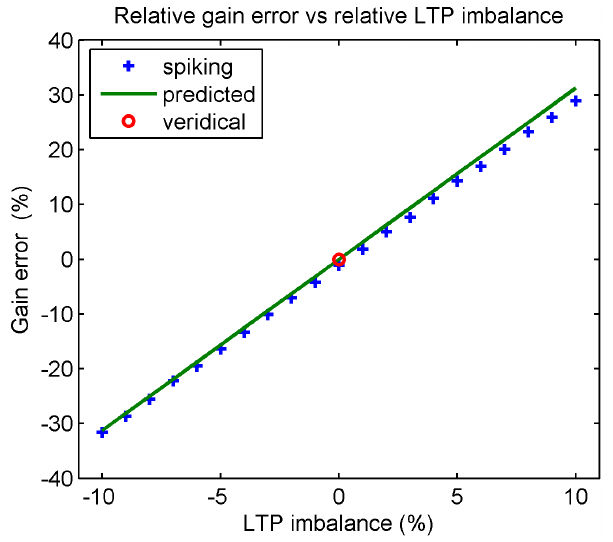
Figure 12. Effect of LTP/LTD imbalance: Stability of brainstem learning rule in the closed loop. The blue crosses show the result of applying the iSTDP learning rule with varying levels of LTP/LTD imbalance to an MVN neuron with a unit amplitude 3 Hz sinusoidal vestibular input x . As outlined in Fig. 10 the corrective cerebellar input was set to y ~ w { g ð Þ x as w varied during learning. Both x and y were Poisson rate-coded with tonic rates of 50 spikes/sec and a modulation depth of 40 spikes/sec. LTP imbalance was measured as the percentage excess of the area of the positive Gaussian over the negative Gaussian in theiSTDPprofile (otheriSTDPprofile parameters werechosenasinFig.8). The target gain was g ~ 1 . For moderate levels of imbalance learning produced a stable limitingweight w . Forzero imbalance the target gain is all expressed in the MVN weight w , hence we used 100 w { g ð Þ as a measure of the percentage weight error caused by the imbalance. This is also the percentage VOR gain error that would be observed if the cerebellar contribution was removed. The observed linear dependence is well predicted by the idealised iSTDP profile shown in Fig. 2 (green curve) for which the learned weight can be calculated analytically as m x m y w ~ 1 z e where k x , k y are the peak modulations of the two inputs k x k y and e is the relative imbalance in LTP. Weight error calculated using this approximation is plotted as a green